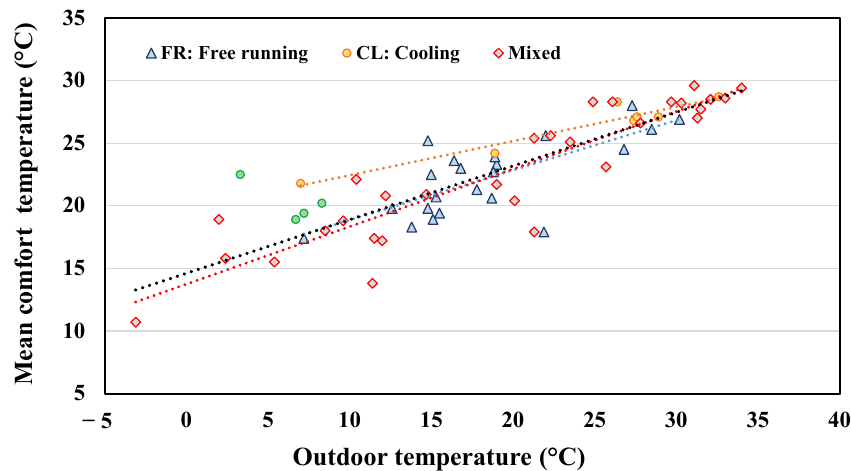
Figure 9. Correlation of mean comfort temperature with outdoor temperature.